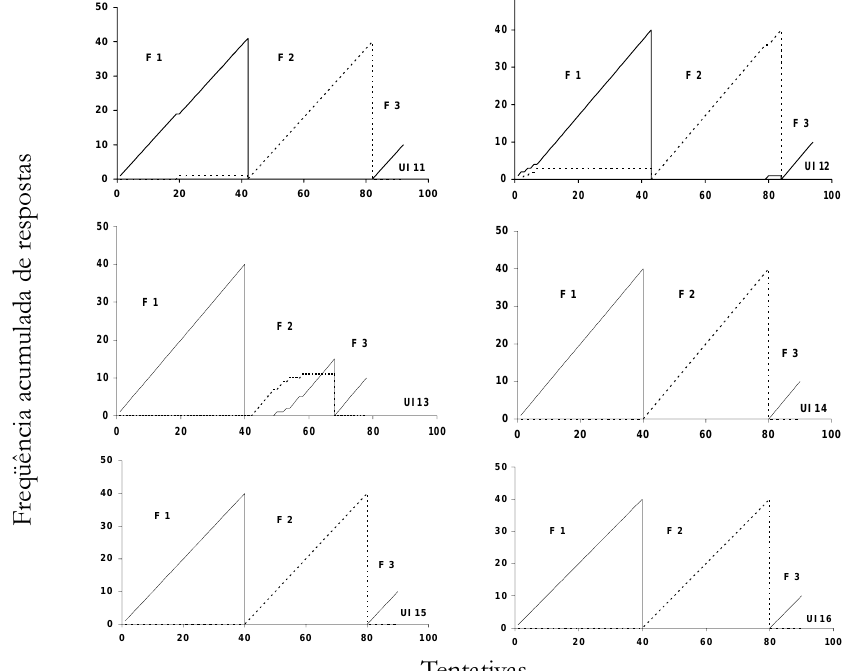
Tentativas Figura 1. Freq(cid:252)Œncia acumulada de respostas nªo-verbais corretas (linha s(cid:243)lida) e incorretas (linha tracejada ), para cada participante (UI) da Condi(cid:231)ªo ’(cid:218)nica Instru(cid:231)ªo’, durante cada fase (F) experimental. Quebras na curva acumu- lada indicam mudan(cid:231)as de fase. Na Fase 1, as instru(cid:231)ıes correspondiam (cid:224)s contingŒncias. As contingŒncias em Psicologia: Reflexªo e Cr(cid:237)tica, 2004, 17(3),